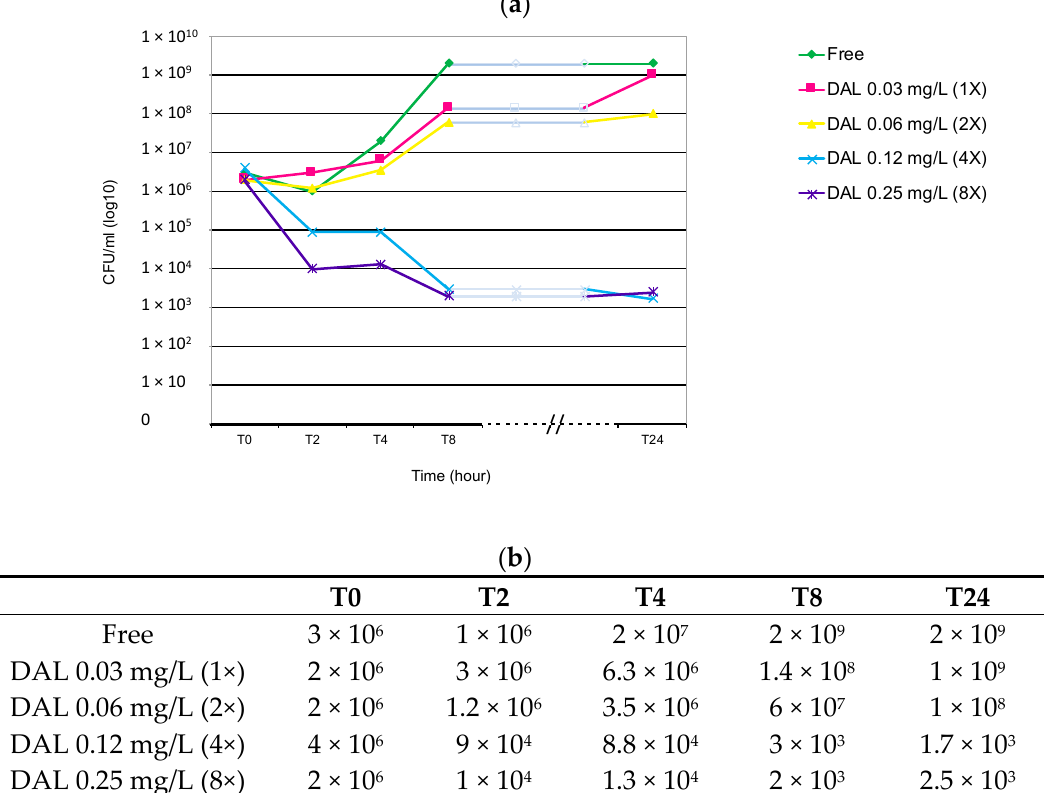
Figure 1. E-MRSA15 ST22-IVh-t223 MIC (1X) 0.03mg / L: ( a ) Graph of curves obtained. ( b ) Average of duplicate viable counts (CFU / mL) observed at T0-T2-T4-T8 and T24 time intervals and after exposure to different concertation of dalbavancin (1-2-4 and 8X MIC). DAL: dalbavancin. Time (hour): 0, 2, 4, 8 and 24 h after the starting inoculum . The red row represents the threshold of bactericidal activity ( ≥ 3 log 10 decrease). Against the RIF-R / hVISA strain belonging to ST228-SCC mec I spa -type t041, dalbavancin bactericidal activity was exhibited at the higher concentration assayed of 4 mg / L (8X MIC) at 8 and 24 h intervals, and a non-bactericidal reduction of only 1 log 10 at lower concentrations (1 and 2 mg / L), at 24 h (Figure